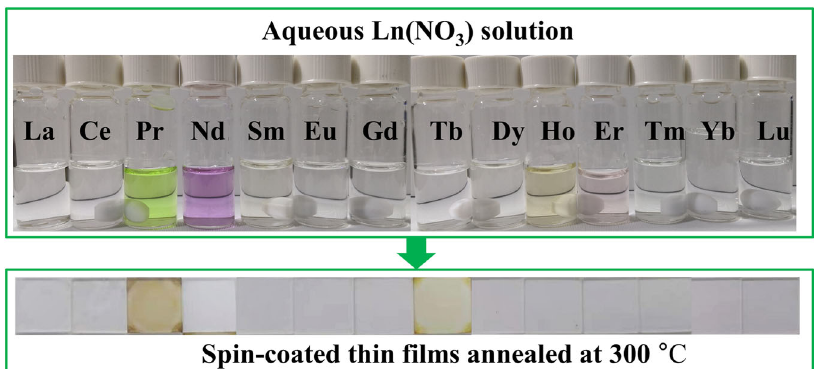
Fig. 1 Ln(NO) 3 ·nH 2 O aqueous solutions and LnO x fi lms. The photos of the different aqueous Ln(NO) 3 ·nH 2 O solutions (0.4 M) and the corresponding spin-coated fi lms annealed at 300 °C.